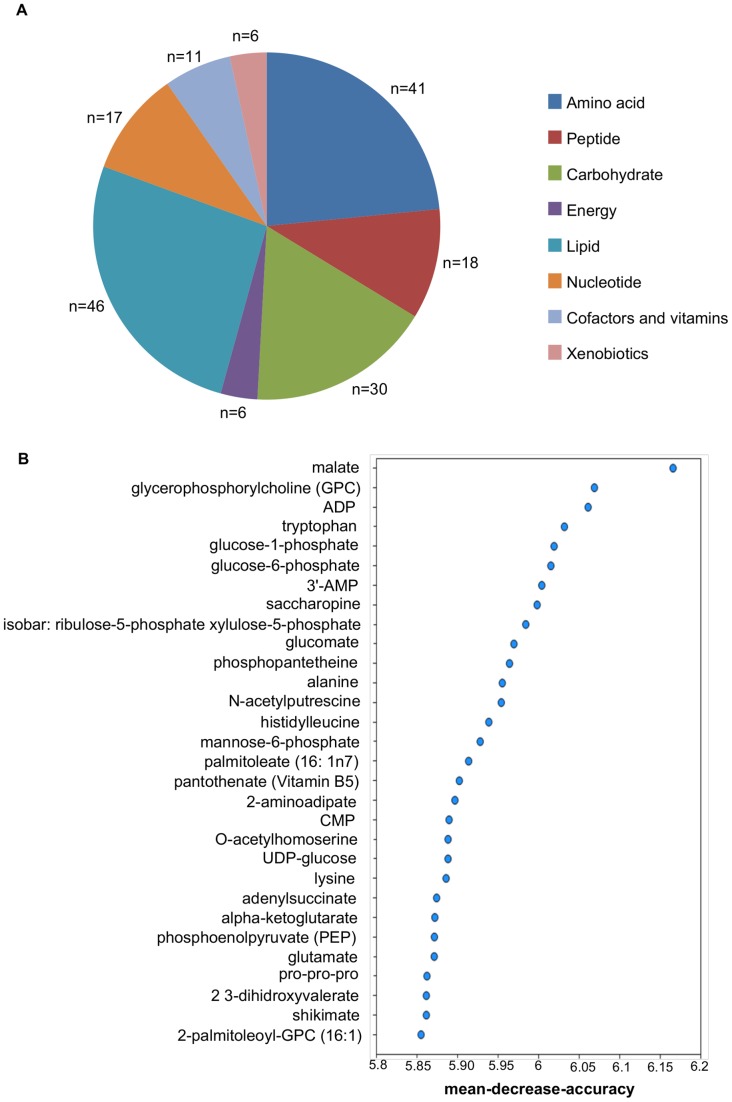
Principal metabolic differences between Sc and Su at 12°C.A) Class distribution of the different identified metabolites. n  =  number of metabolites in each class. B) The Random Forest statistical analysis of metabolomic data was used to identify the top 30 biochemicals with the greatest influence in distinguishing the different groups. Metabolites are listed on the y-axis in order of importance, with importance decreasing from top to bottom. The mean decrease in accuracy for each metabolite is plotted on the x-axis.